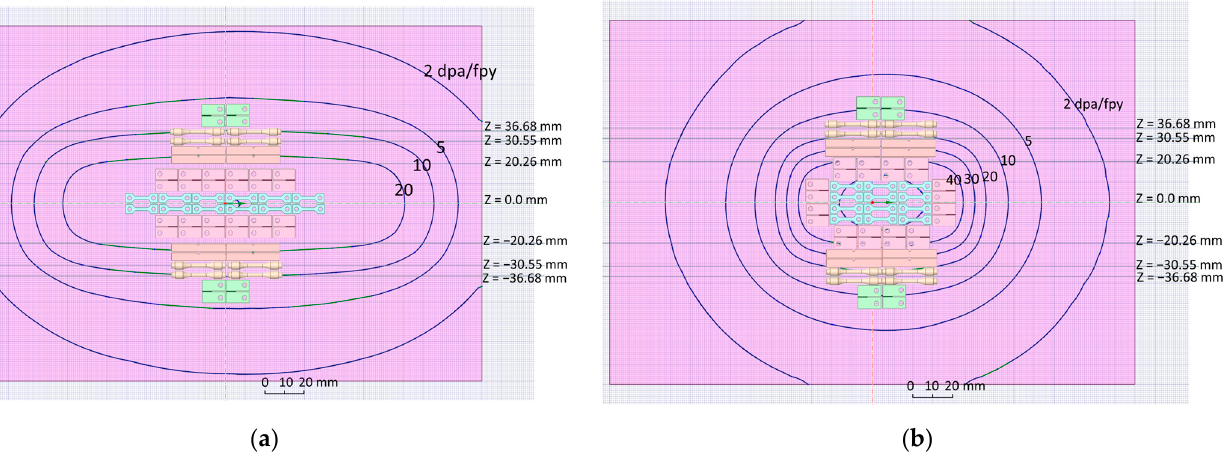
Figure 14. The specimen arrangements for BP with two footprints using the 2.3 mm-thick BP option. The descriptions of colors and lines are similar to Figure 12. ( a ) “20 × 5”; ( b ) “10 × 5”. Table 3. Obtainable DPA values (dpa/fpy) for the specimens based on the arrangement shown in Figure 14.